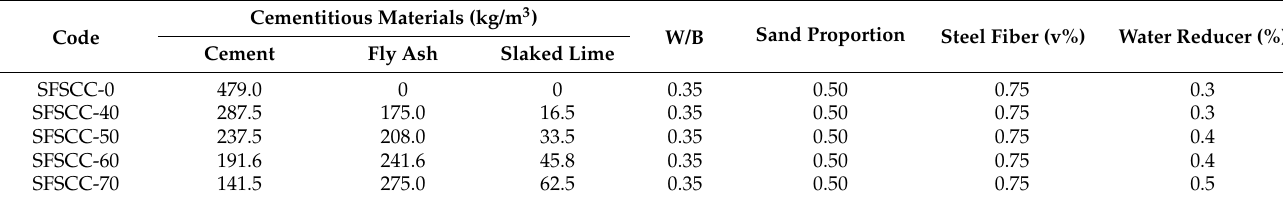
Table 3. The mix proportion of